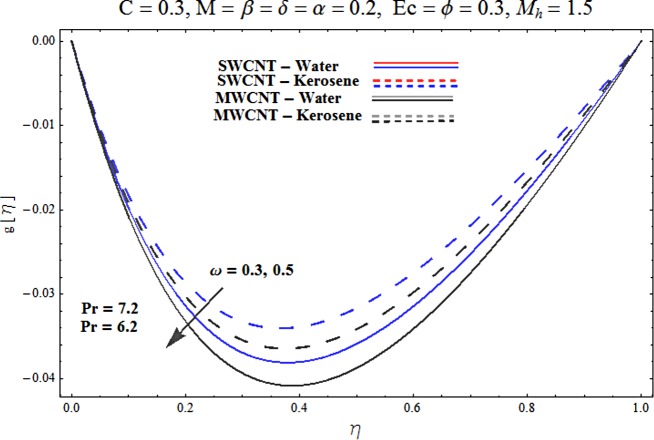
Effect of ω on g′.